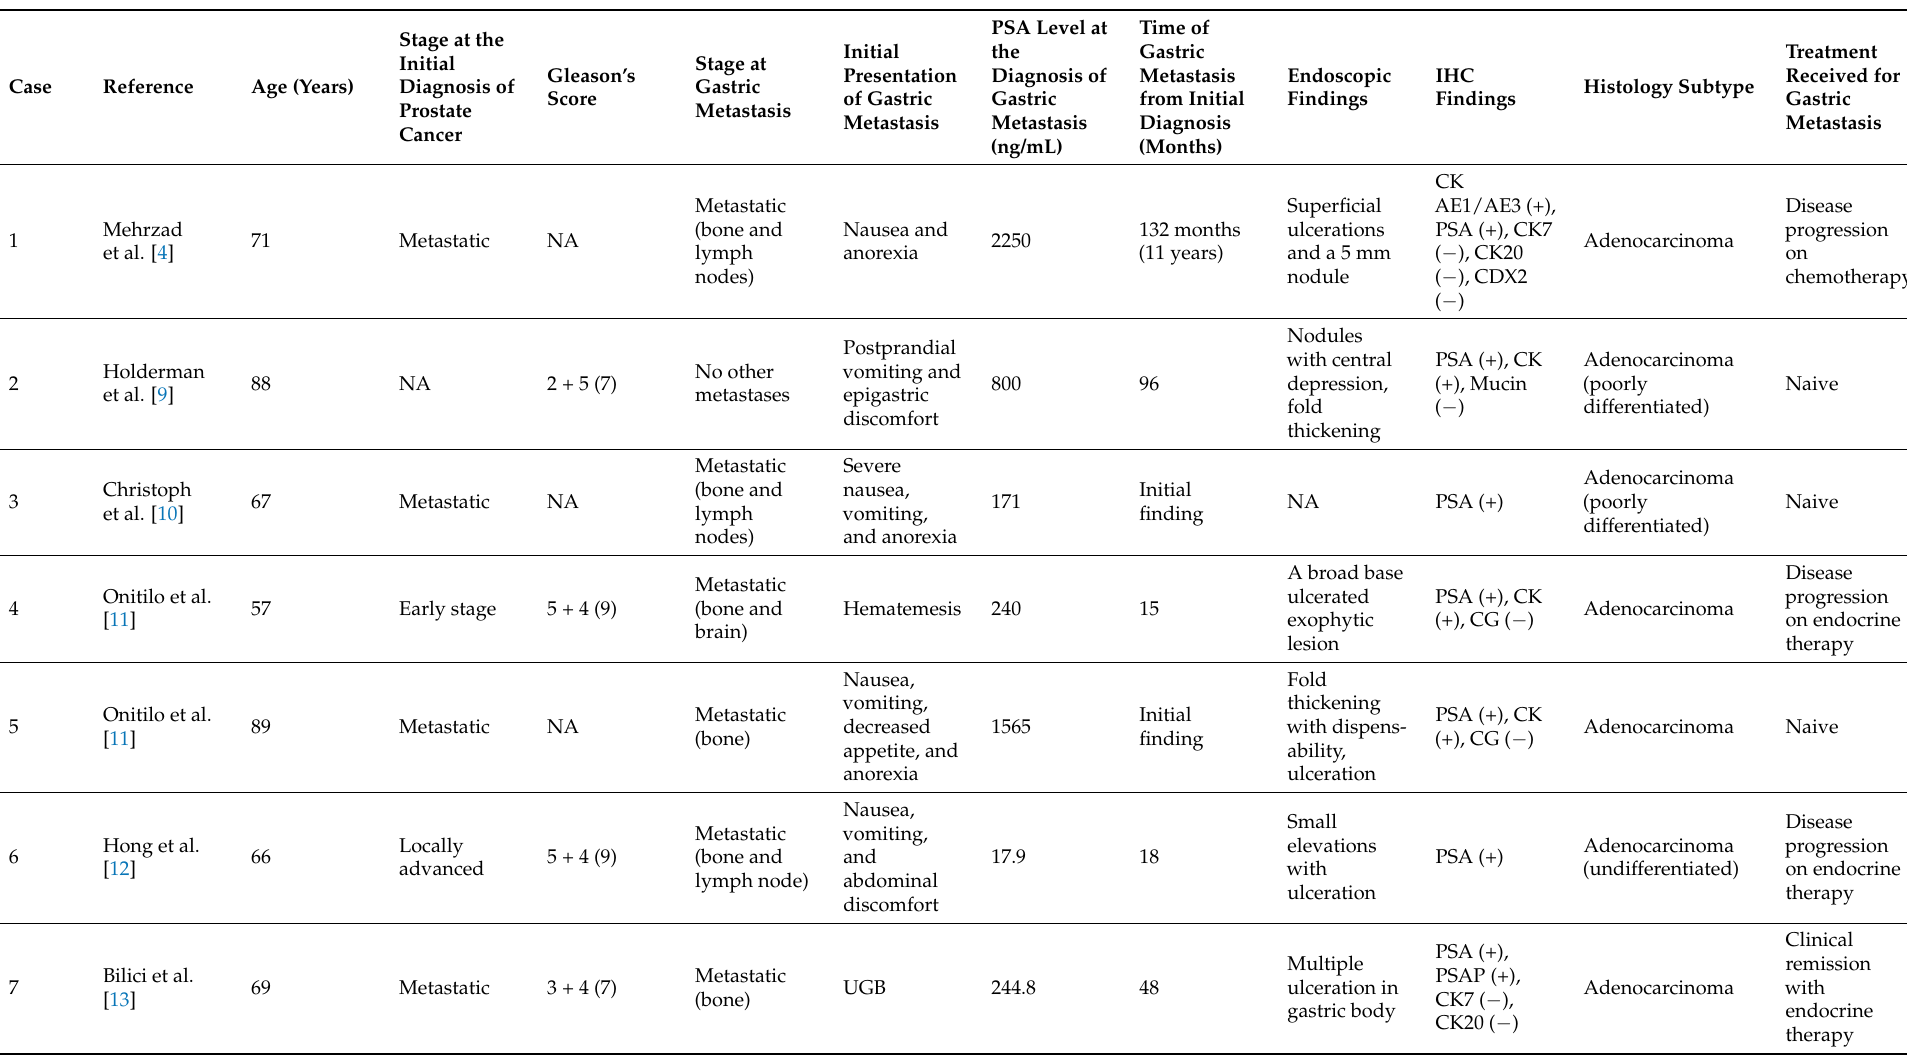
Table 1. Published studies of prostate cancer metastasis to